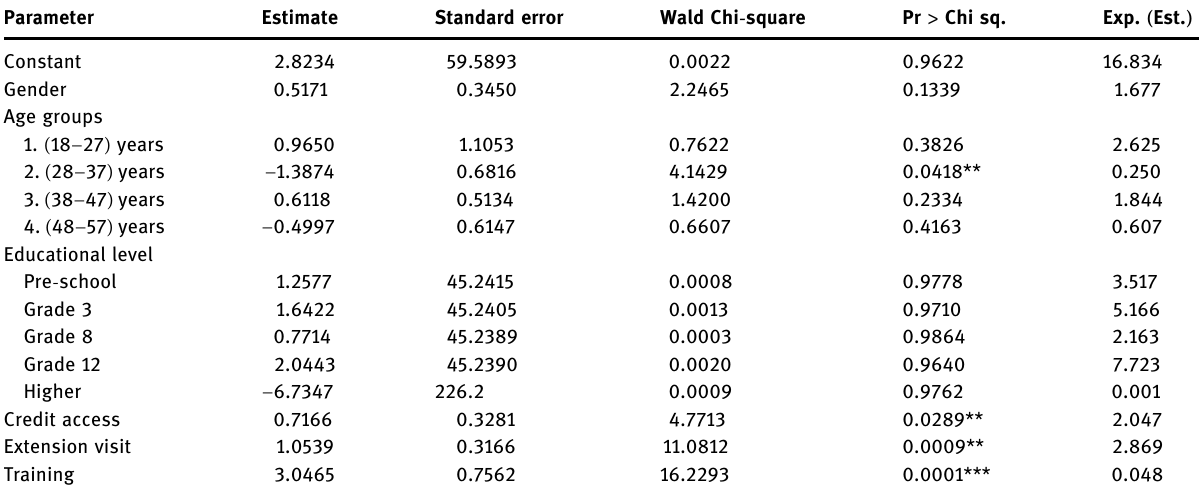
Table 3: Logistic regression results on factors a ff ecting adoption of CA